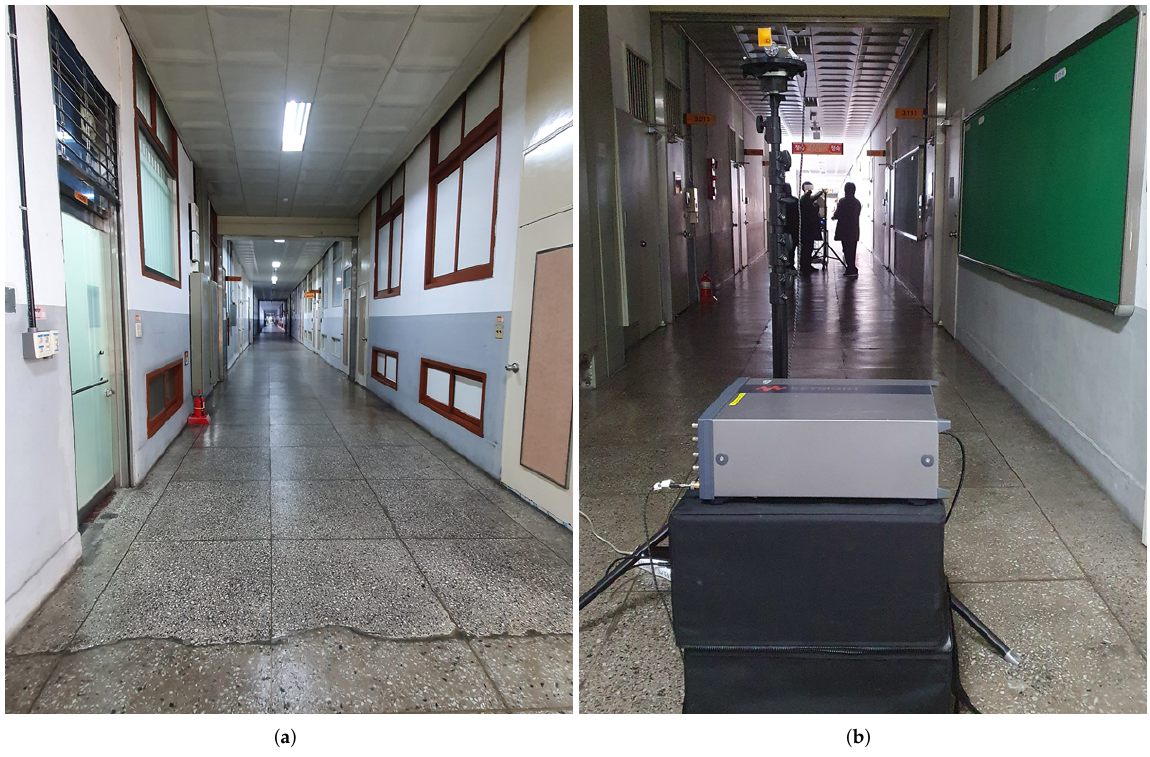
Figure 5. ( a ) The figure shows the 375 m-long corridor without human movement on the 3rd floor of the main building just before the measurement campaign; and ( b ) it shows a measurement scenario of the 3rd floor corridor of the main